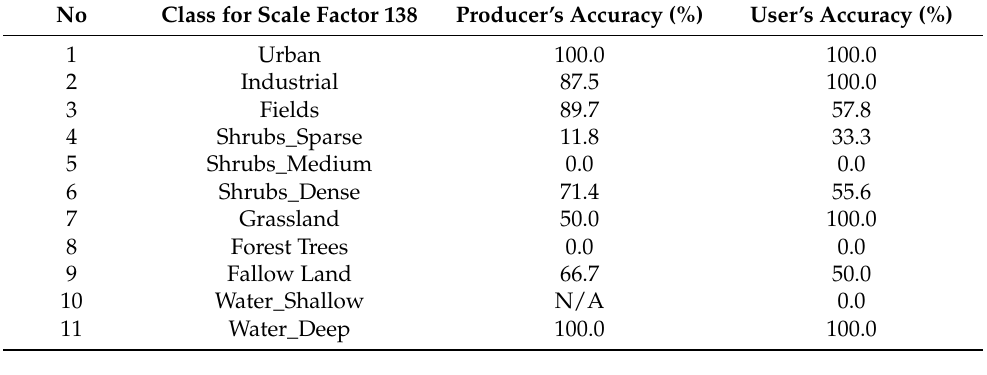
Table 4. The classification results of Sentinel-2 on the 139-scale segmentation.